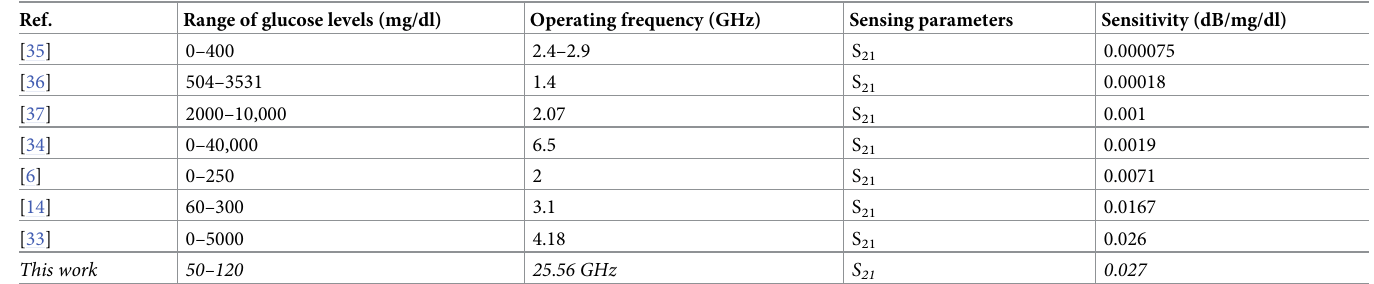
Table 3. Comparison of the designed sensor with previously studied glucose sensors.